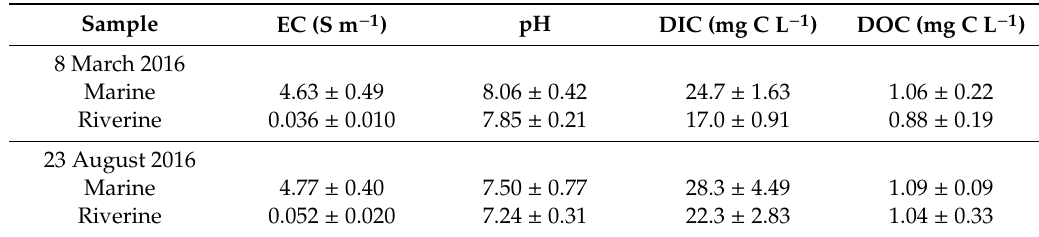
Table 1. Marine and riverine conditions (EC and pH), dissolved inorganic (DIC) and organic carbon (DOC) concentrations in the winter (8 March) and summer (23